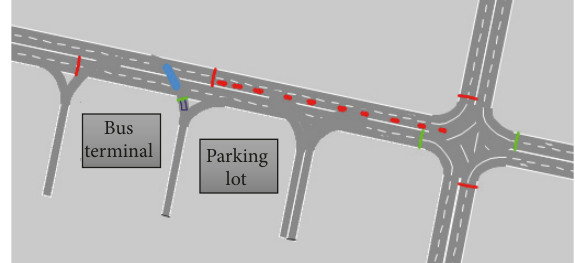
Figure 8: VISSIM network of alternative control design.